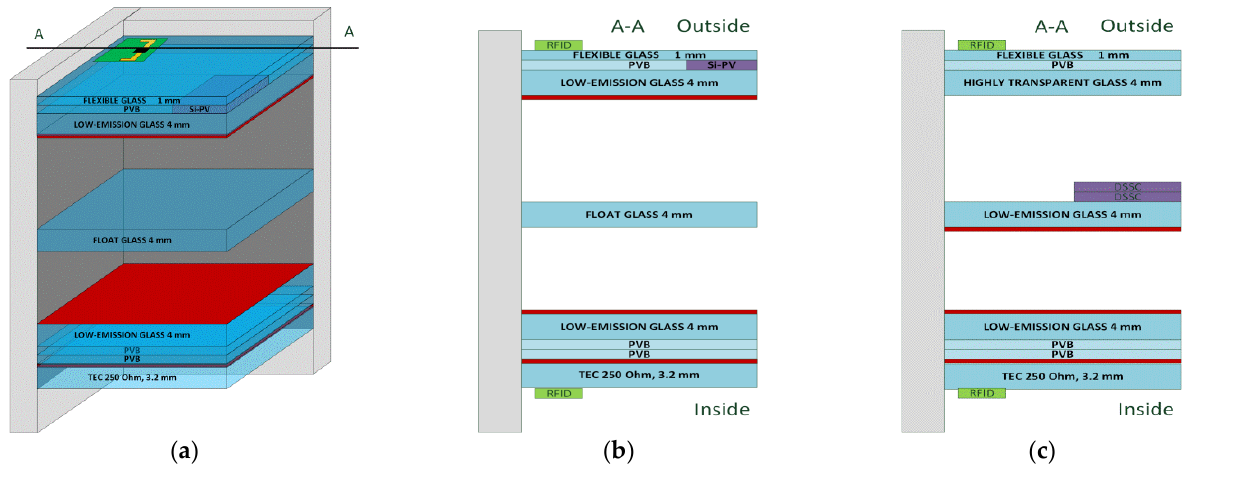
Figure 2. Models of exemplary active glazing units: ( a ) spatial model with Si-PV cells; ( b ) cross-section of model with Si-PV cells; ( c ) cross-section of model with DSSC cells. Real proportions are not respected for the sake of clarity of the drawings; TCO layers are marked in red.